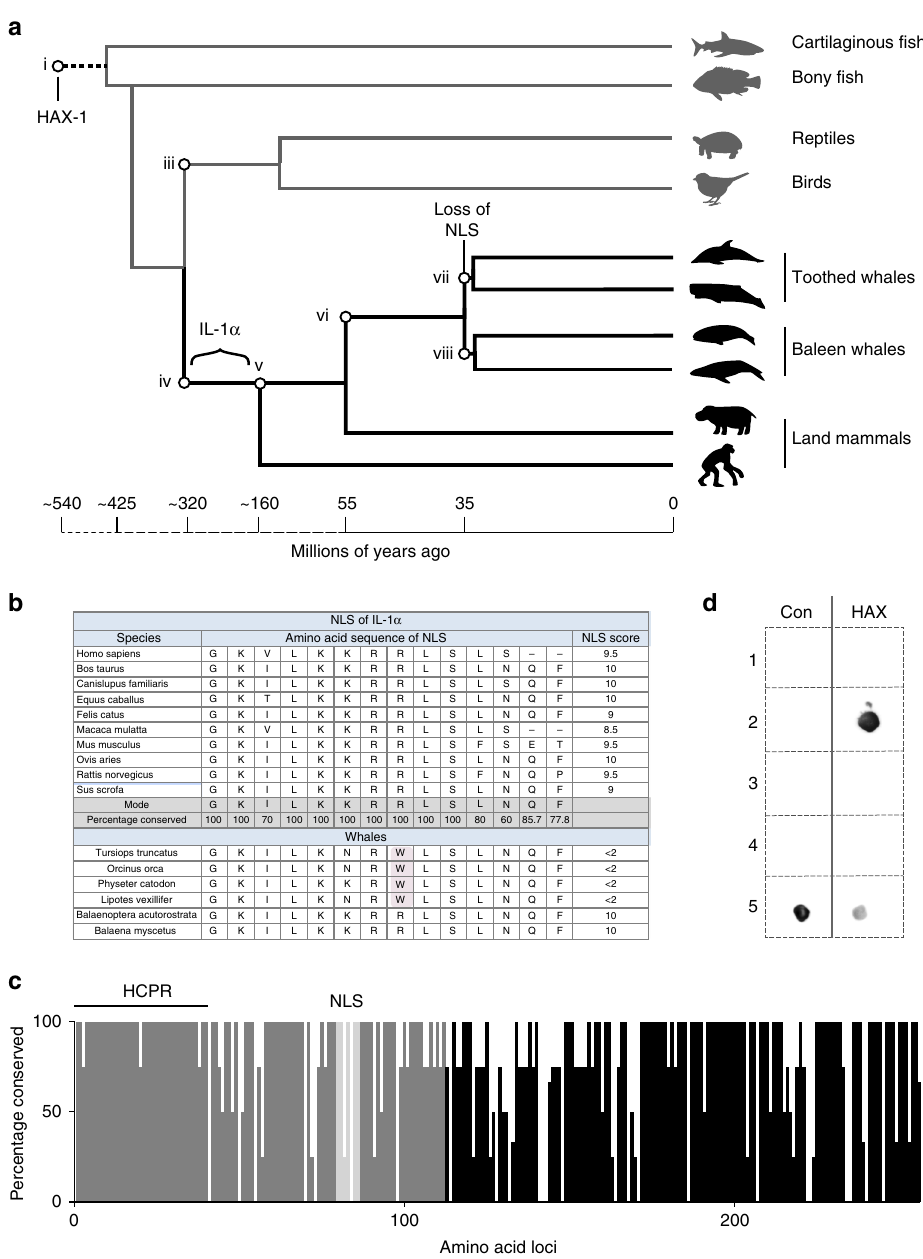
Fig. 4 The evolutionary importance of HAX-1 to IL-1 α . a A model evolutionary tree with time scale of cartilaginous and body fi sh, birds, reptiles, mammals and baleen and toothed whales 54,55 . HAX-1 is expressed in all vertebrate species as well as hemichordates, suggesting that it emerged during the Cambrian explosion (i); IL-1 β evolved approximately 425 million years ago (ii); IL-1 α formed via a gene duplication event of IL-1 β in the common ancestor of all mammals (Synapsid lineage) (iv). The NLS of IL-1 α is present in all land mammals and baleen whales, suggesting it was present in the common ancestor of all mammals (v) and the common ancestor of all whales (vi); all toothed whales lack a functional NLS, suggesting that the common ancestor of the toothed whale (vii) had a loss of function mutation in the NLS. b The amino acid sequences of the IL-1 α NLS, including the percentage conservation and the calculated predicted NLS activity (cNLS) scores 63 ; all found in the pro-region in amino acid positions around 70 – 85. Note the loss of a functional NLS in the toothed whale species due in most part to the R to W replacement (highlighted). c The percentage of conserved amino acid sequences of the pro (grey) and mature (black) segments of IL-1 α comparing 4 toothed whale species with the modal land mammal sequence. While the mature segment contains substantial variation due to the build-up of neutral mutations over the 35 million years of evolutionary separation, the pro-IL-1 α domain is highly conserved despite the loss of NLS function. d Dot blot with bovine serum albumin (BSA) (1), pro-IL-1 α (2), mature IL-1 α (3), mature IL-1 β (4) and HAX-1 (5) bound to the membrane (0.02 μ g), then incubated with HAX-1 (5 μ g ml − 1 ) (HAX) or control buffer (Con) to investigate HAX-1 binding. HAX-1 was probed and visualised, and found to exclusively bind to pro-IL-1 α , con fi rming that this binding is speci fi c and substantial to the pro-domain of pro-IL-1